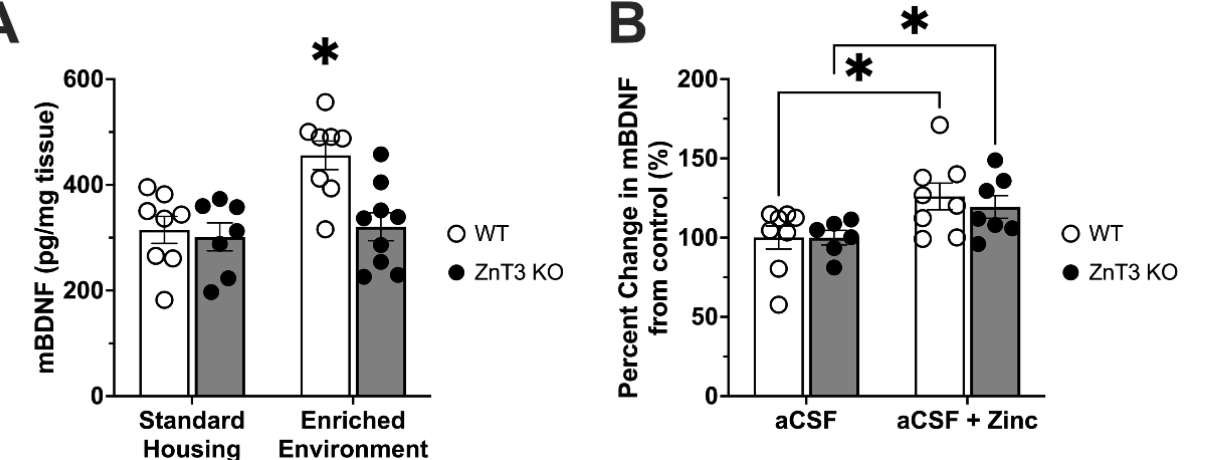
Figure 5. Measurements of mature BDNF (mBDNF) in the hippocampus of WT and ZnT3 KO mice. ( A ) The amounts of mBDNF measured in the hippocampus of WT and ZnT3 KO mice in SH did not differ. EE significantly increased mBDNF in the hippocampus of WT mice but not in ZnT3 KO mice ( n = 32). ( B ) Effect of bath application of 10 µ M ZnCl on mBDNF levels in the hippocampus of WT and ZnT3 KO mice. Exogenously applied Zn significantly increased the level of mBDNF in the hippocampus of both WT and ZnT3 KO mice ( n = 29). Error bars represent ± standard error of the mean. * indicates p <